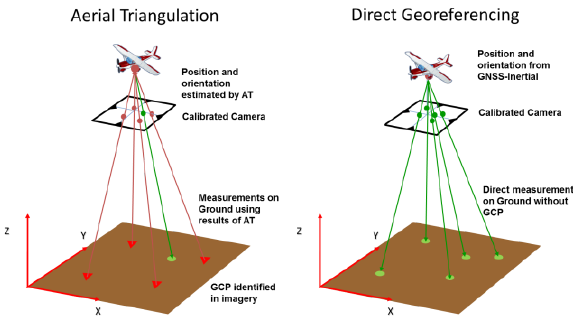
Figure 1: Direct Georeferencing Concept versus Aerial